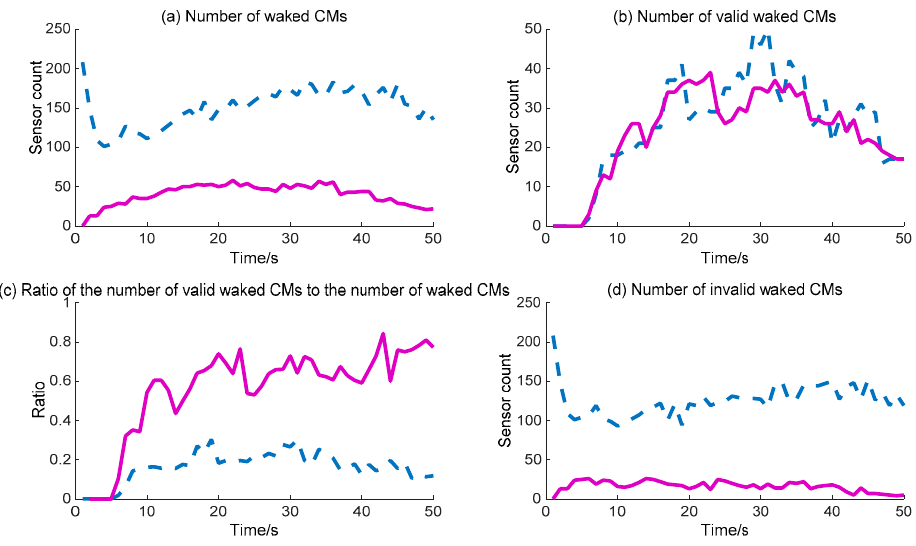
Figure 12. The WC performance of CMs: ( a ) Number of waked CMs. ( b ) Number of valid waked SMs. ( c ) Ratio of the number of valid waked CMs to the number of waked CMs. ( d ) Number of invalid waked CMs. ( — : BDIIM; -- : DIDM). Table 6. Data of the CMs performance of nodes in